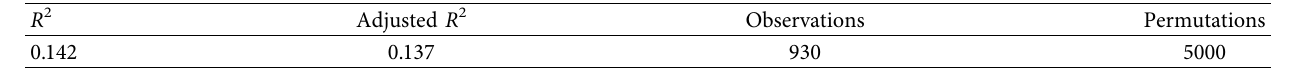
Table 7: Results of model fitting.